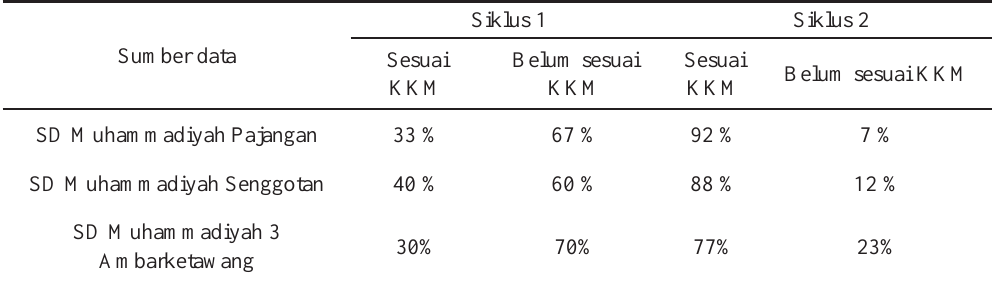
Tabel 3. Rekapitulasi Hasil Peningkatan Siklus 1 dan 2